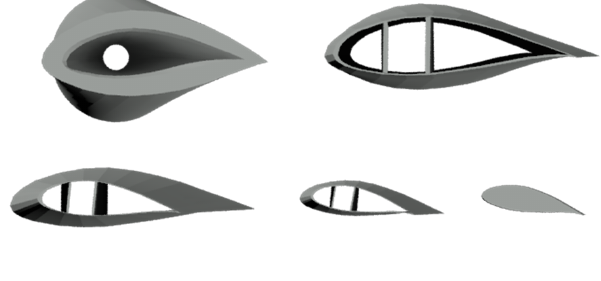
Fig. 2. Blade sections at (top, l-r) 1 m, 3 m, (bottom, l-r) 7 m, 8 m and 8.5 m from root (GFRP material